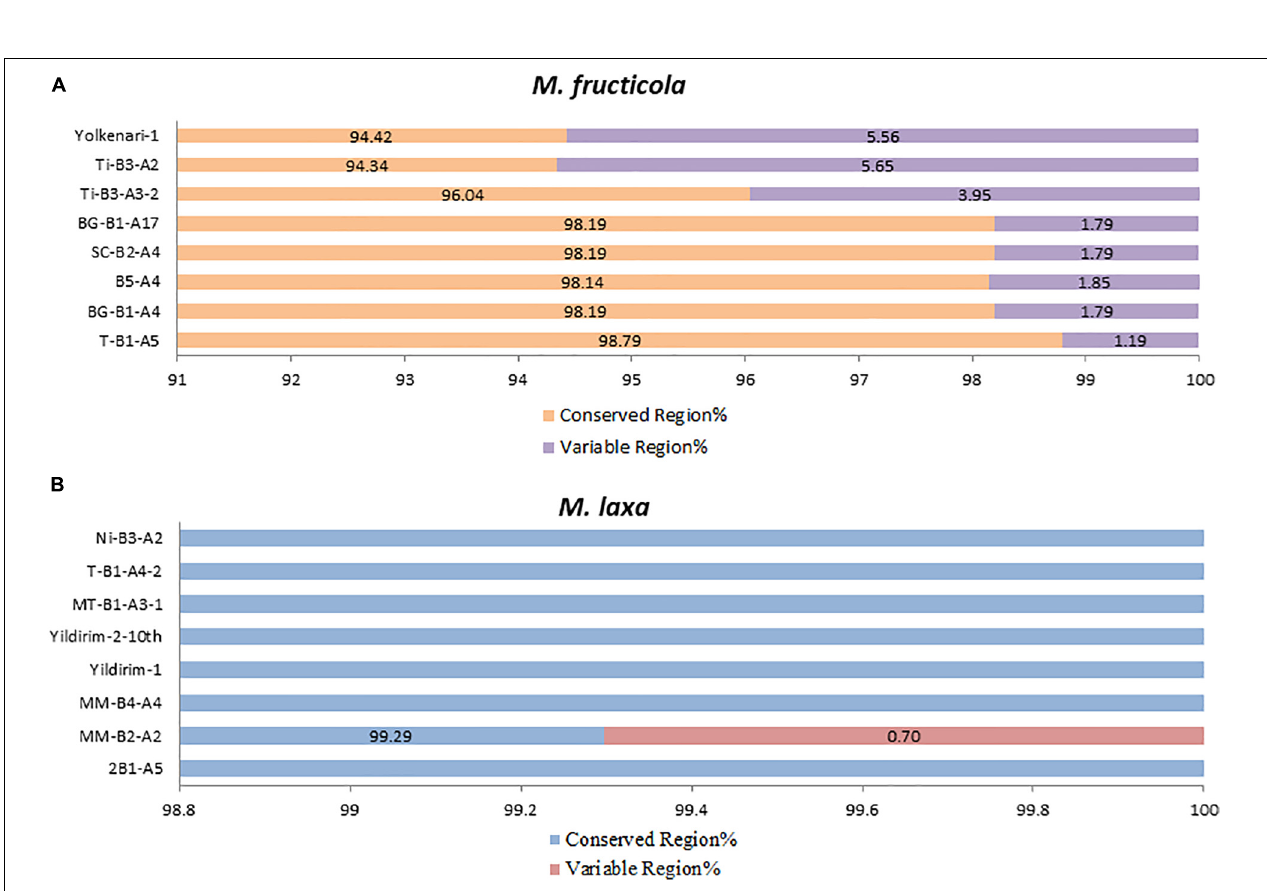
FIGURE 5 | Predicted percentage of conserved and variable regions of the mitogenomes within each species (A) M. fructicola and (B) M. laxa .